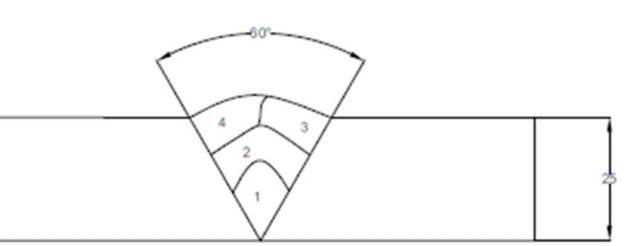
Figure 1. Cross section of the